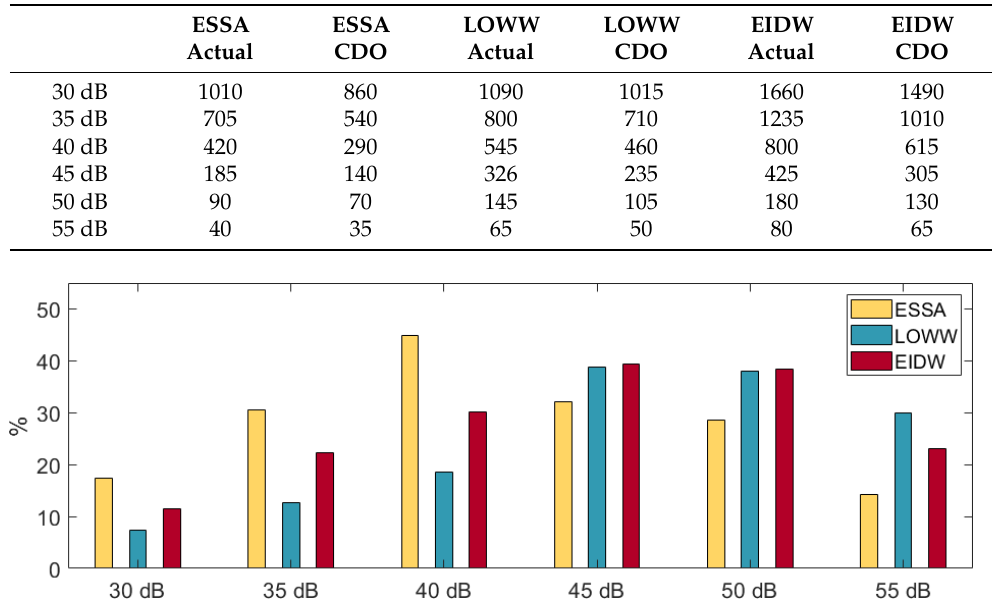
Figure 7. Additional area (in percent) exposed to different levels of noise, for the actual trajectories compared to